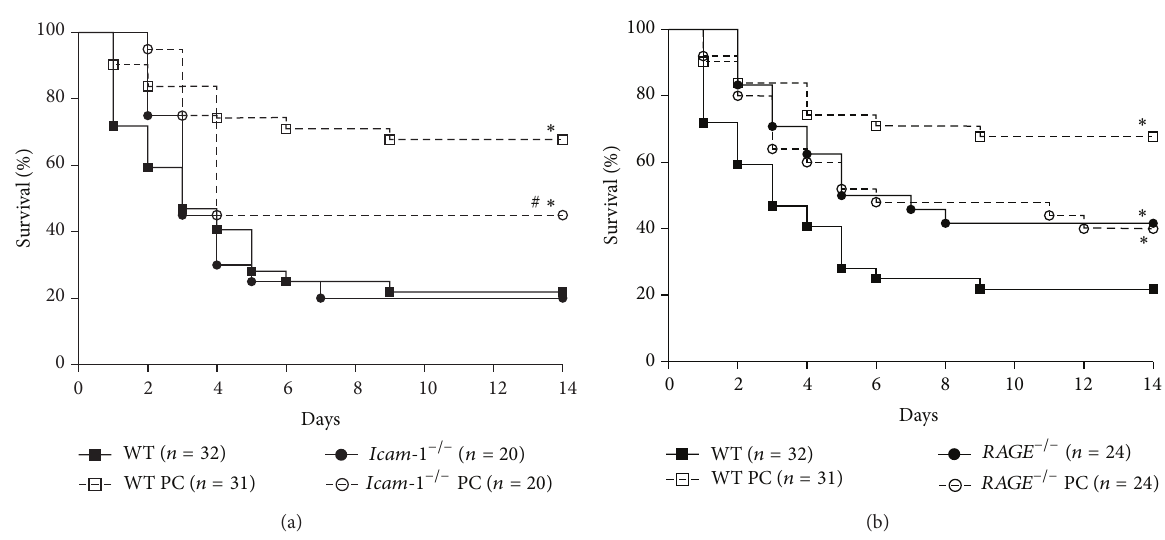
Figure 5: Effect of PC treatment on survival during LPS-induced endotoxemia in wild-type, RAGE −/− , and Icam-1 −/− mice. Lethal endotoxemia was induced by Escherichia coli LPS (serotype 055:B5, 40mg/kg i.p.) and treated with PC (100U/kg, i.p.) or human albumin (8mg/mL) as controls at 0.5, 8, and 24 h after LPS challenge. Survival is shown in Kaplan-Meier plots for the respective treatments in Icam-1 −/− mice (a) and RAGE −/− mice (b) and compared to WT mice. Significant differences by log-rank test were set at 𝑃 < 0.05 and indicated by